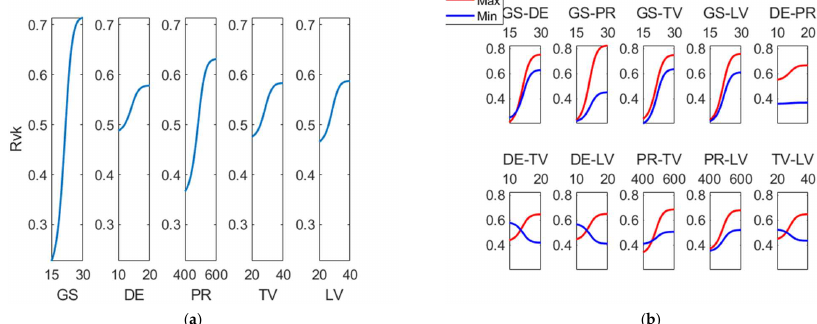
Figure 10. ( a ) Main effects plot and ( b ) interaction effects plot for (Rvk (µm)). Figure 11 corresponds to the surface response plots for (Mr1) and Figure 12 depicts both the main effect plot and the interaction effects plot for (Mr1). It can be observed that